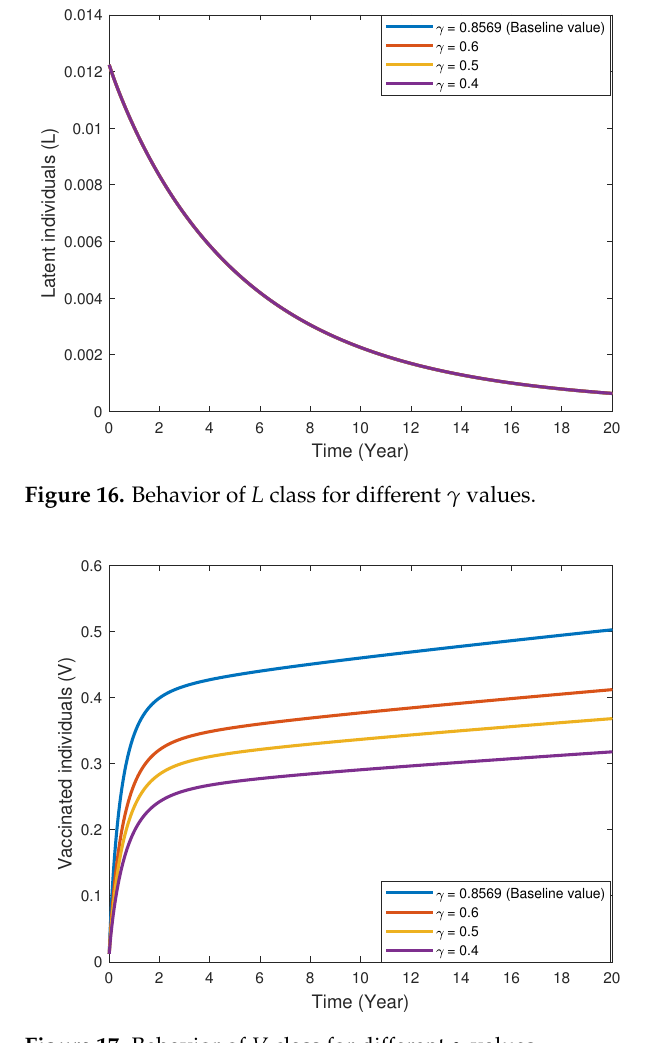
Figure 17. Behavior of V class for different γ values. In Figure 18, the time variation of susceptible individuals for different ψ = 0.1989, ψ = 0.3, ψ = 0.4 and ψ = 0.5 values of ψ is examined. Here, ψ = 0.1989 is the value